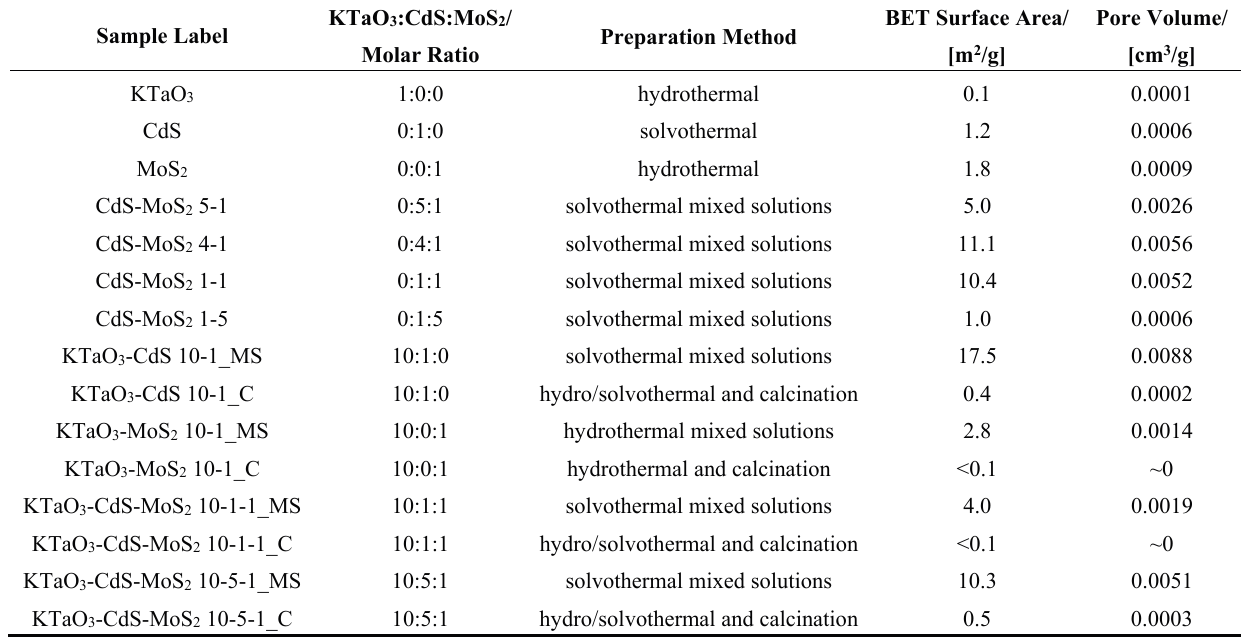
Table 1. Sample label, preparation method, BET surface area and pore volume of obtained single semiconductors and their